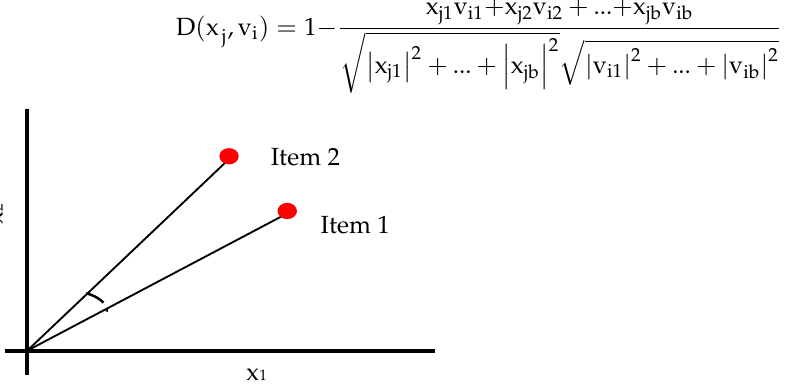
Figure 4. Schematic Diagram of Cosine Distance Measures.